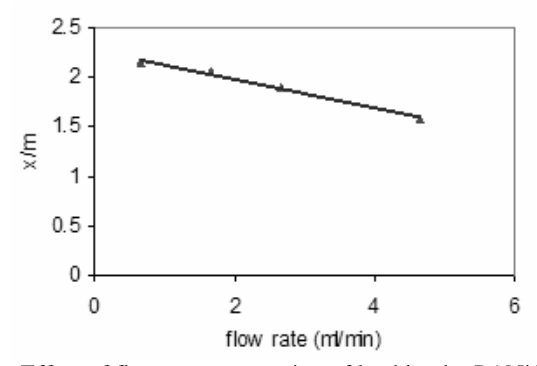
Figure 12 . Effect of flow rate on sorption of lead ion by PANi/SD column